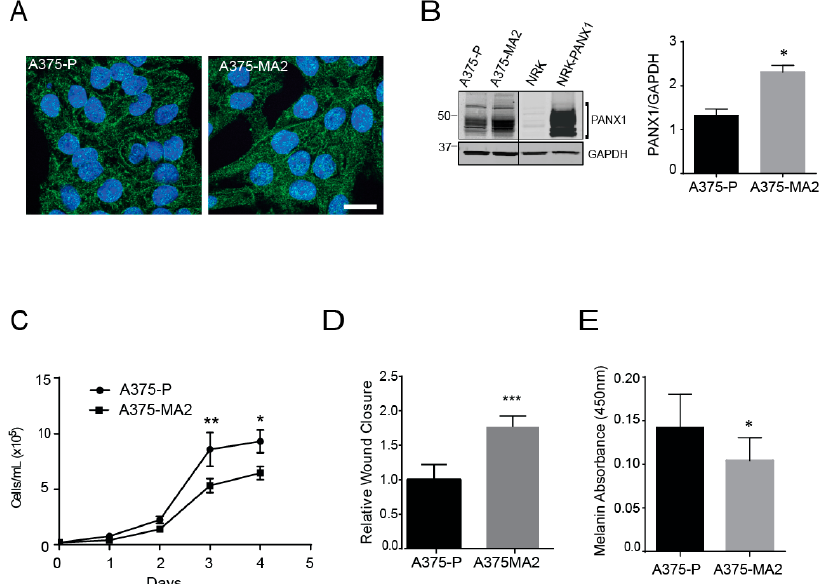
Figure 3. Pannexin 1 is expressed in established human melanoma cell lines. ( A ) A375-P and A375-MA2 human melanoma cells were fixed and stained with anti-PANX1 polyclonal antibodies (green). DNA was stained with Hoechst (blue). Bar: 20 μ m. Representative fields are shown from three separate experiments. ( B ) A375-P, A375-MA2, Normal Rat Kidney cells (NRK), and NRK overexpressing PANX1 (NRK-PANX1) cells were lysed and equal amounts of protein were resolved by SDS-PAGE. The blots were probed with the anti-PANX1 antibodies. Black line denotes that both images are from the same blot but scanned with different intensity. Right panel shows the quantification of PANX1 bands in A375-P and A375-MA2 samples using ImageStudio 3.0. The data are expressed as means ±SEM (N = 4) Statistical analyses using student’s t -tests; * p < 0.05. ( C ) A375-P and A375-MA2 melanoma cells were cultured at 20,000 cells per well in medium containing 10% FBS. Cells were counted daily up to 4 days after initial seeding of the cells onto the 24-well culture dish. The data are expressed as mean ± SEM (N = 5, n = 25). Two-way ANOVA was used to statistically analyze data. * p < 0.05, ** p < 0.01. ( D ) Scratch assays were performed on a confluent monolayer of A375-P and A375-MA2 cells to assess migration. Quantifications represents cell migration three days following the initial scratch and treatment application. Statistical analysis was performed using student’s t -tests; *** p < 0.001. ( E ) Melanin was extracted from one million A375-P and A375-MA2 cells. There was significantly decreased melanin content detected in A375-MA2 compared to A375-P cells at the same passage number. Statistical analyses for melanin extraction data includes student’s t -tests; * p <